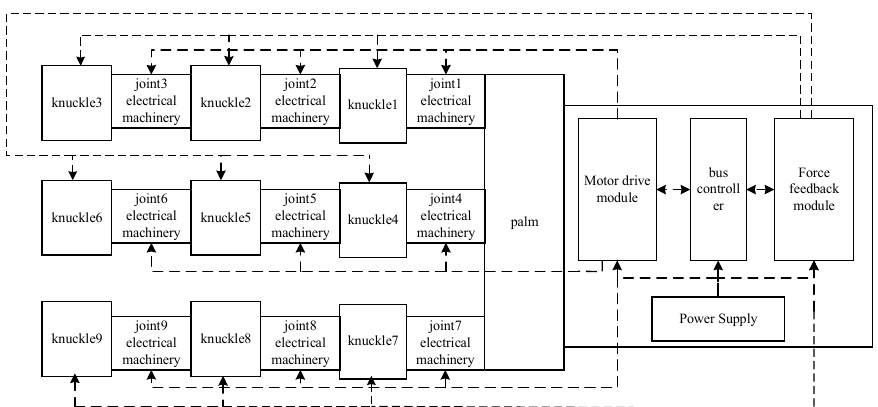
Figure 7. Tomato picking end-e ff ector control system.